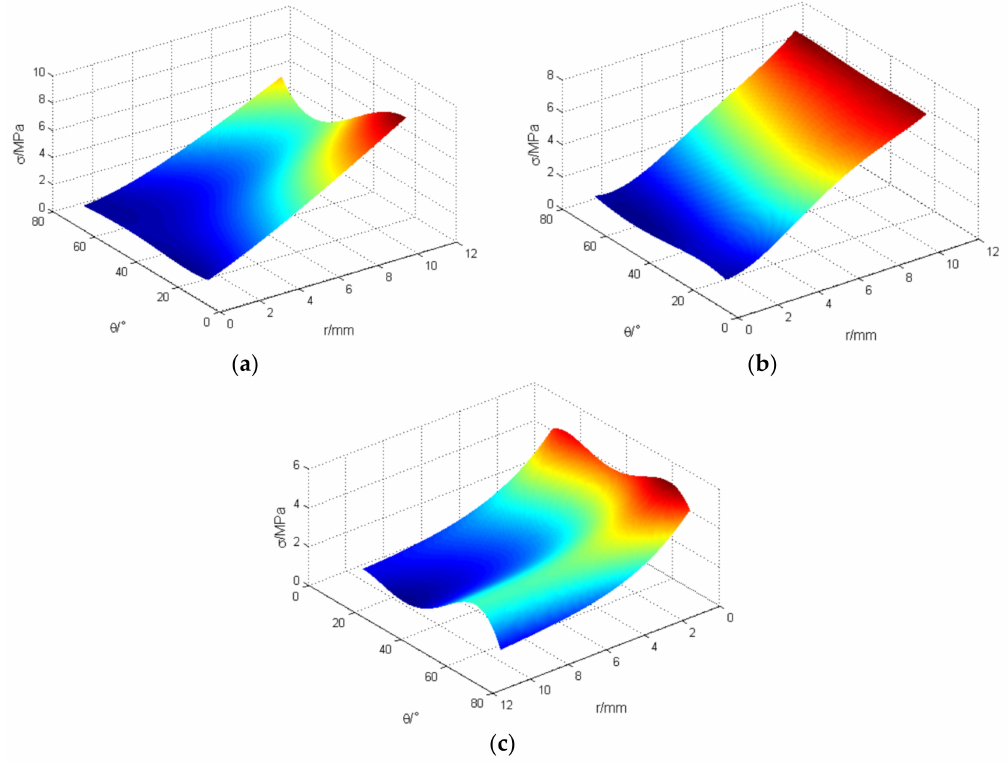
Figure 15. Response surfaces of mean stress for origami honeycomb: ( a ) in the in-plane direction along the y -coordinate, ( b ) in the in-plane direction along the x -coordinate, and ( c ) in the out-of- plane direction.